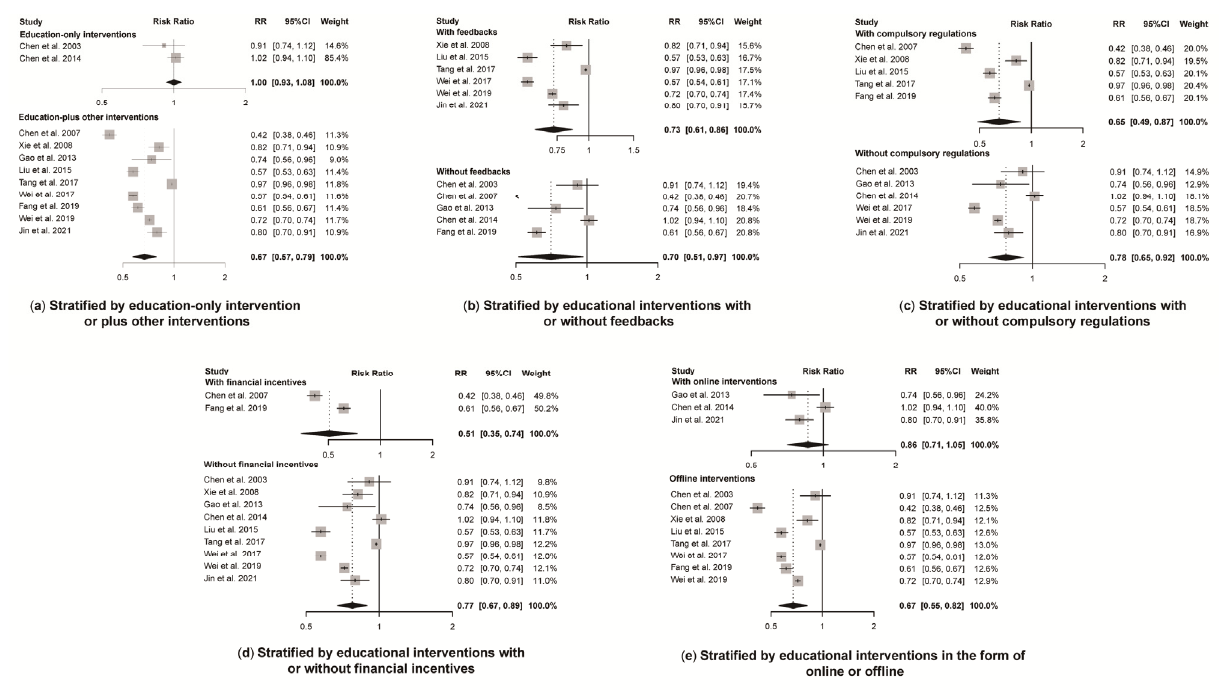
Figure 4. Effect of educational interventions with certain features on antibiotic prescription rate.